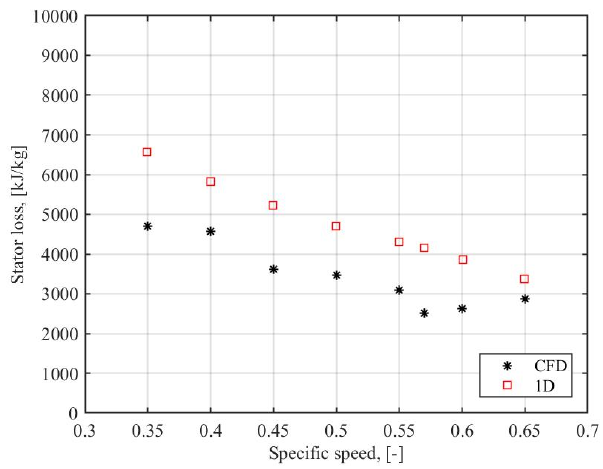
Figure 4. The comparison of CFD results and the results of 1D stator loss model.